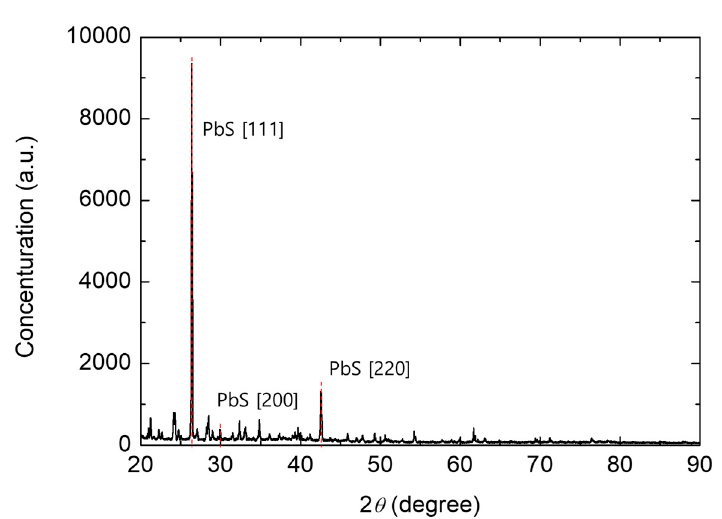
Figure 7. The X-ray diffraction (XRD) results of the synthesized quantum dot. In the graph, PbS [111] shows the highest intensity, and PbS [220] shows the next highest intensity. Each points of peak were detected at the specific points which correspond to the crystallinities of conventional PbS.